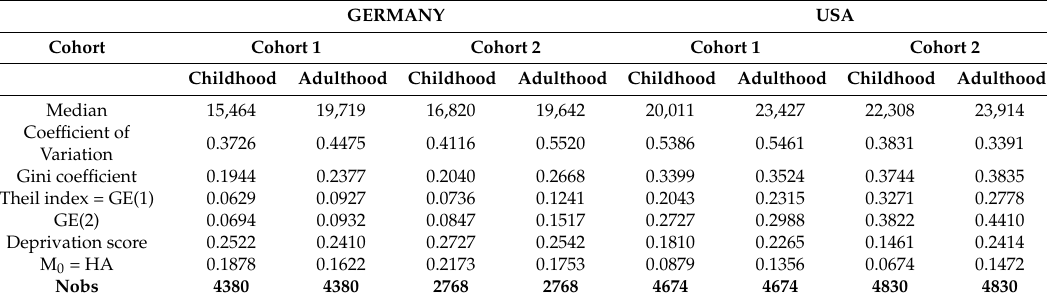
Table 3. Inequality, and capability deprivation—permanent real equivalent household